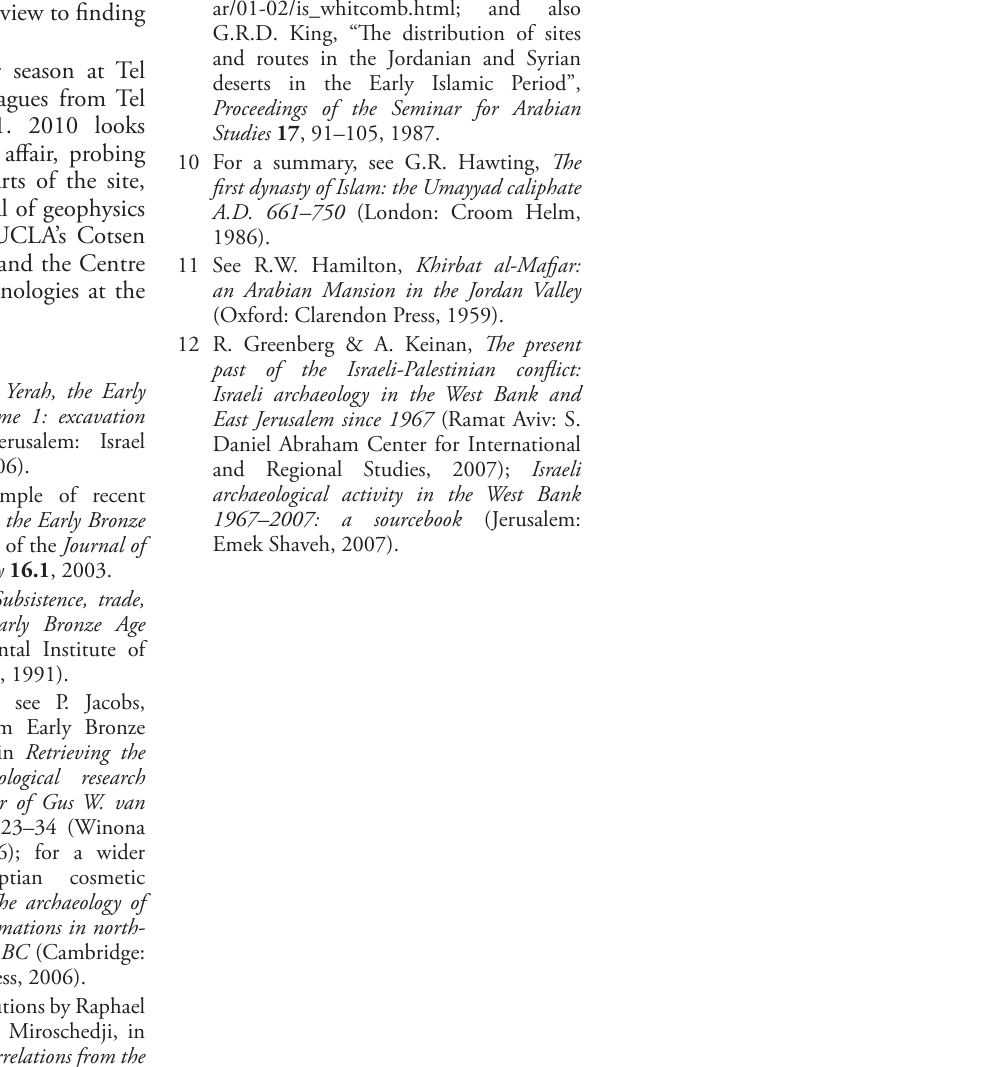
Figure 7 Example of a shepherding outpost in a natural topographic basin in the southern survey